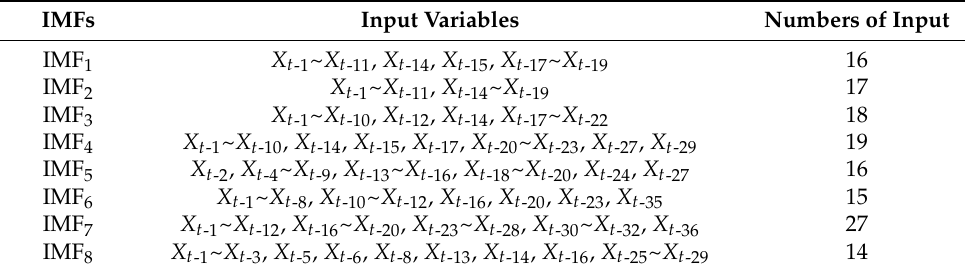
Table 1. Optimal input variables of each IMF for Yichang Hydrological station.